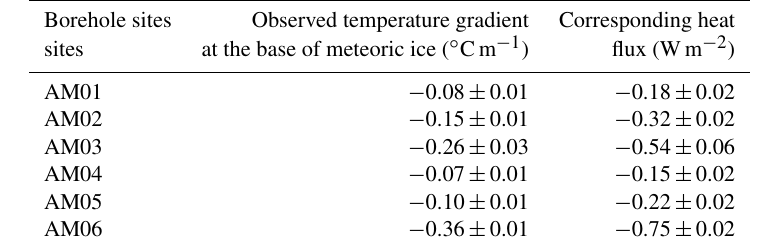
Figure 6. Borehole temperature profiles (a) at AM01, AM04 and AM05 (with marine ice) and (b) at AM02, AM03 and AM06 (without marine ice). The subplot of (a) is the near-isothermal section of AM05, fitted with an in situ seawater freezing line for a salinity of 34.4psu. Markers ( + ) and (o) indicate the thermistor points. The depth ranges (lower left of a ) mark impermeable (solid line) and permeable (dotted line) marine ice layers from Fig. 5a. The temperatures of the upper and lower surfaces at AM03 and AM04 are inferred from available AWS data and the surface air temperature field (Comiso, 2000), represented by dotted lines. Table 3. Observed temperature gradients and derived corresponding heat fluxes at the base of the meteoric ice at the six borehole sites. The heat flux is calculated according to Fourier’s law, including the fact that thermal conductivity of ice, k ice , is a function of ice temperature as shown in Table